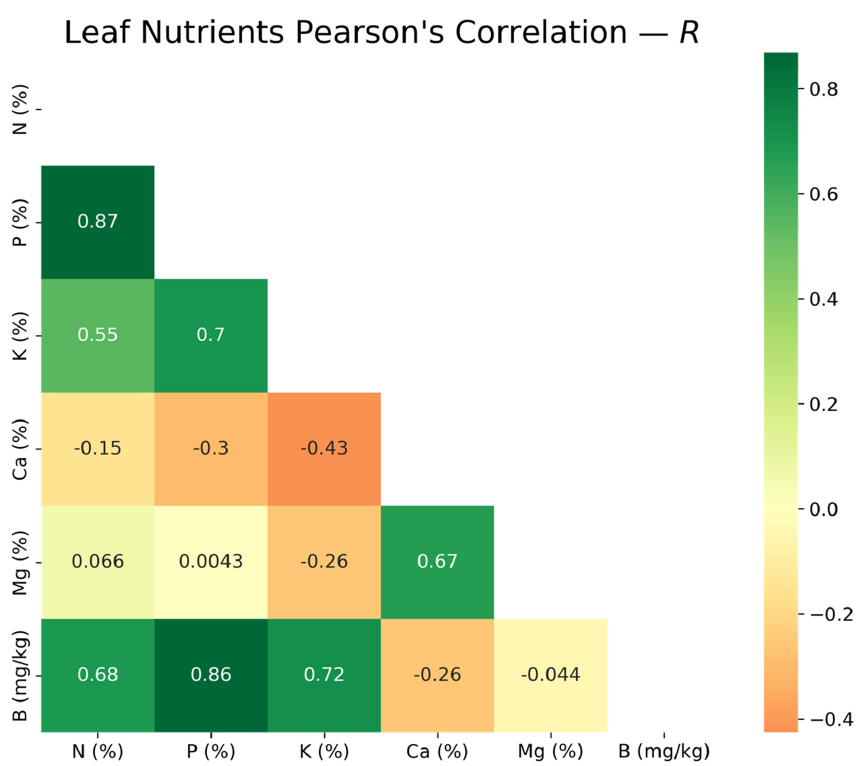
Figure 6. Correlations between individual nutrients in the grapevine leaf samples are shown as a heatmap, with values for Pearson’s correlation, R. There are two primary groups of mutually correlated nutrients: N–P–K–B and Ca–Mg. While many bands were selected in the SWIR range, these bands will be highly vari- able due to the differences in water stress and imperfect atmospheric compensation. The higher frequency of selected bands near the edges of the removed spectral bands is par- ticularly worrisome. In multiple linear regression models with limited samples, these par- ticularly variable bands may slightly improve the regression by chance while not actually being related to the target nutrient. Some studies of nitrogen contents using hyperspectral data obtained with handheld spectrometers have demonstrated improvements with ni- trogen-related SWIR bands [66,67]. However, SWIR bands may be impractical and cost- prohibitive to the development of a multispectral sensing UAS solution for the grapevine nutrient status, given the need for more expensive detector materials and even cooling requirements [23]. 4.5. Future Research and Potential Improvments A major potential improvement to achieving optimized spectral models from hyper- spectral imagery is the implementation of a hyperspectral downwelling light sensor. The current practice for radiometric correction is to use field-deployed calibration panels with well-characterized spectral properties as a reference in UAS imagery. The calibration pan- els cannot be present every moment the push-broom spectrometer is traversing the vine- yard, so any variation in the illumination conditions that occurs between visits to the pan- els results in a radiometric correction error. Unfortunately, the best that can be done to mitigate this error is to manually choose the panel spectra most closely representing the conditions present during each swath of imagery when applying the empirical line method. A downwelling light sensor that obtains spectral data of the sky both spatially